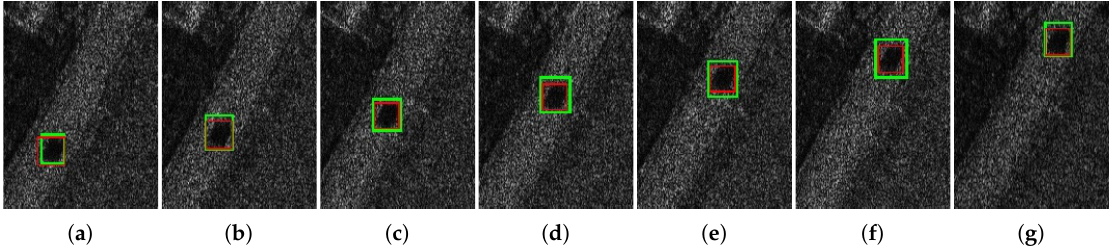
Figure 14. Partial tracking results of kernelized correlation filter (KCF) of simulated video-SAR data. Green rectangles are the true trajectory of target, and red rectangles represent tracking results. ( a – g ) are the corresponding results of frame 1, 10, 20, 30, 40, 50 and 60, respectively.